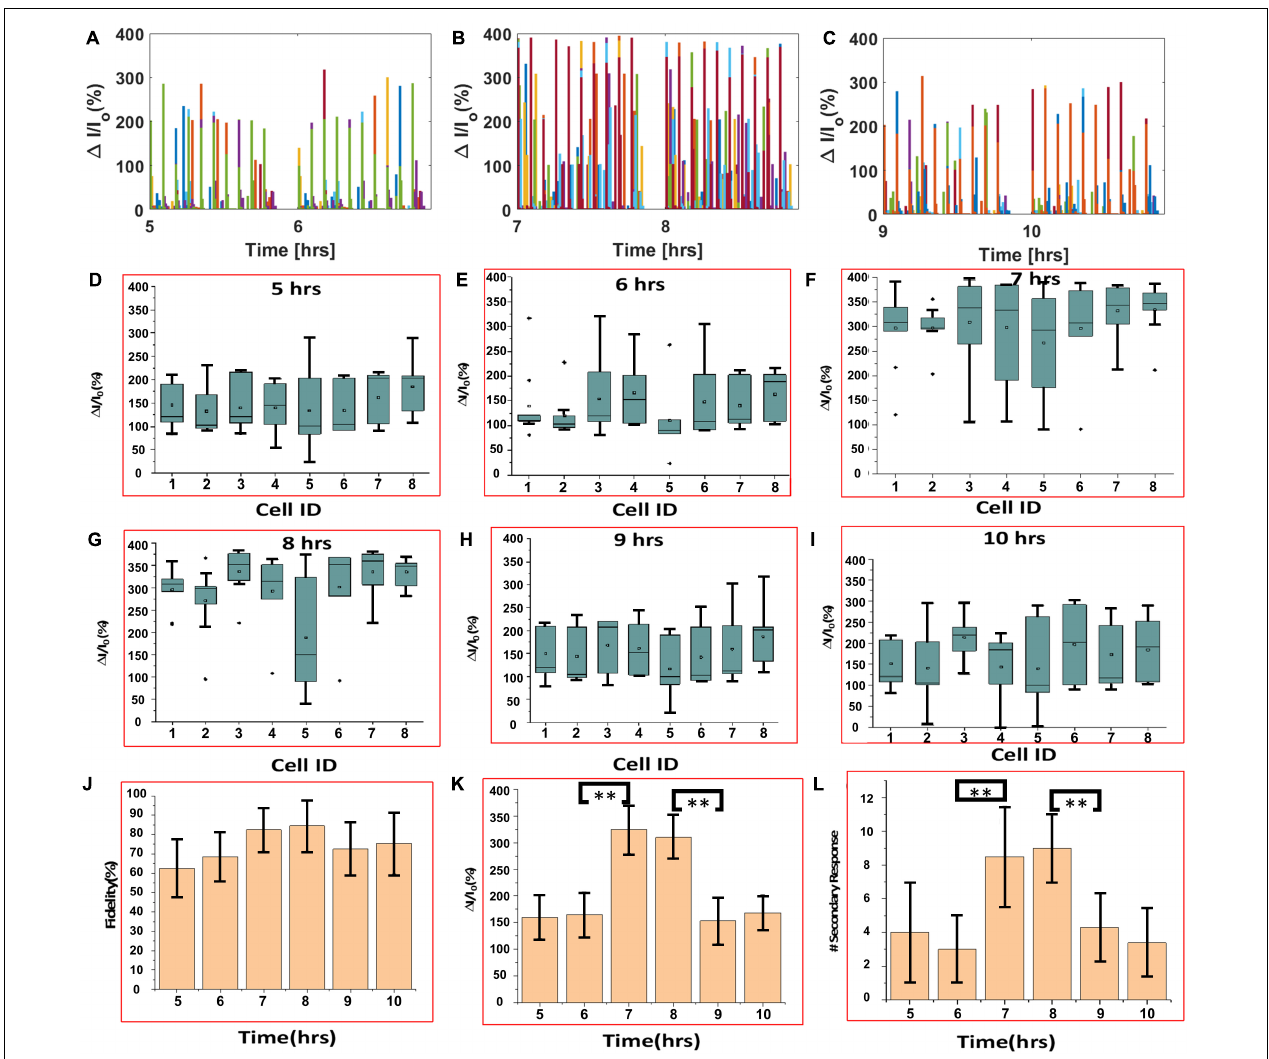
FIGURE 5 | Analysis of continuous, extended in vivo visually evoked Ca 2 + -bioluminescence activities in the bMCOII-transduced visual cortex of mice. (A–C) Ca 2 + bioluminescence changes for 5–6, 7–8, and 9–10 h, respectively. (D–I) Box plots showing average bioluminescence primary responses in the 5 th , 7 th , 9 th , 6 th , 8 th , and 10 th hours, respectively, for each of the eight assigned neurons. (J) Fidelity, (K) fractional increase in primary bioluminescence signal, and (L) number of secondary responses from the eight assigned neurons. N = 10 stimulations. Av. ± SD. * p < 0.05 and ** p <